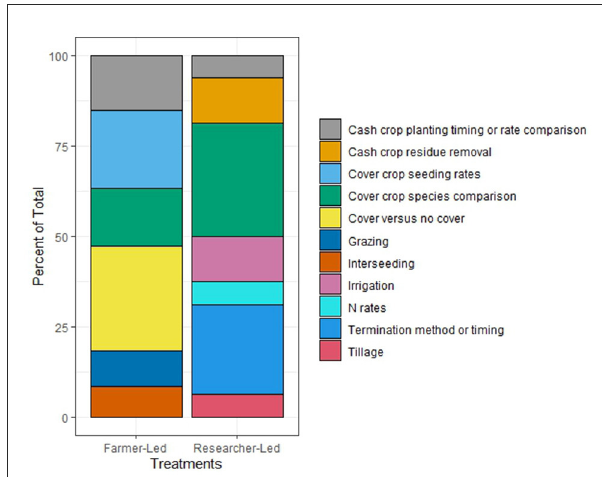
FIGURE1 Experimental treatments used in farmer-led ( n = 89) and researcher-led trials ( n = 290). The bar graph shows the percentage of studies or observations that used a certain treatment out of the total number of studies.